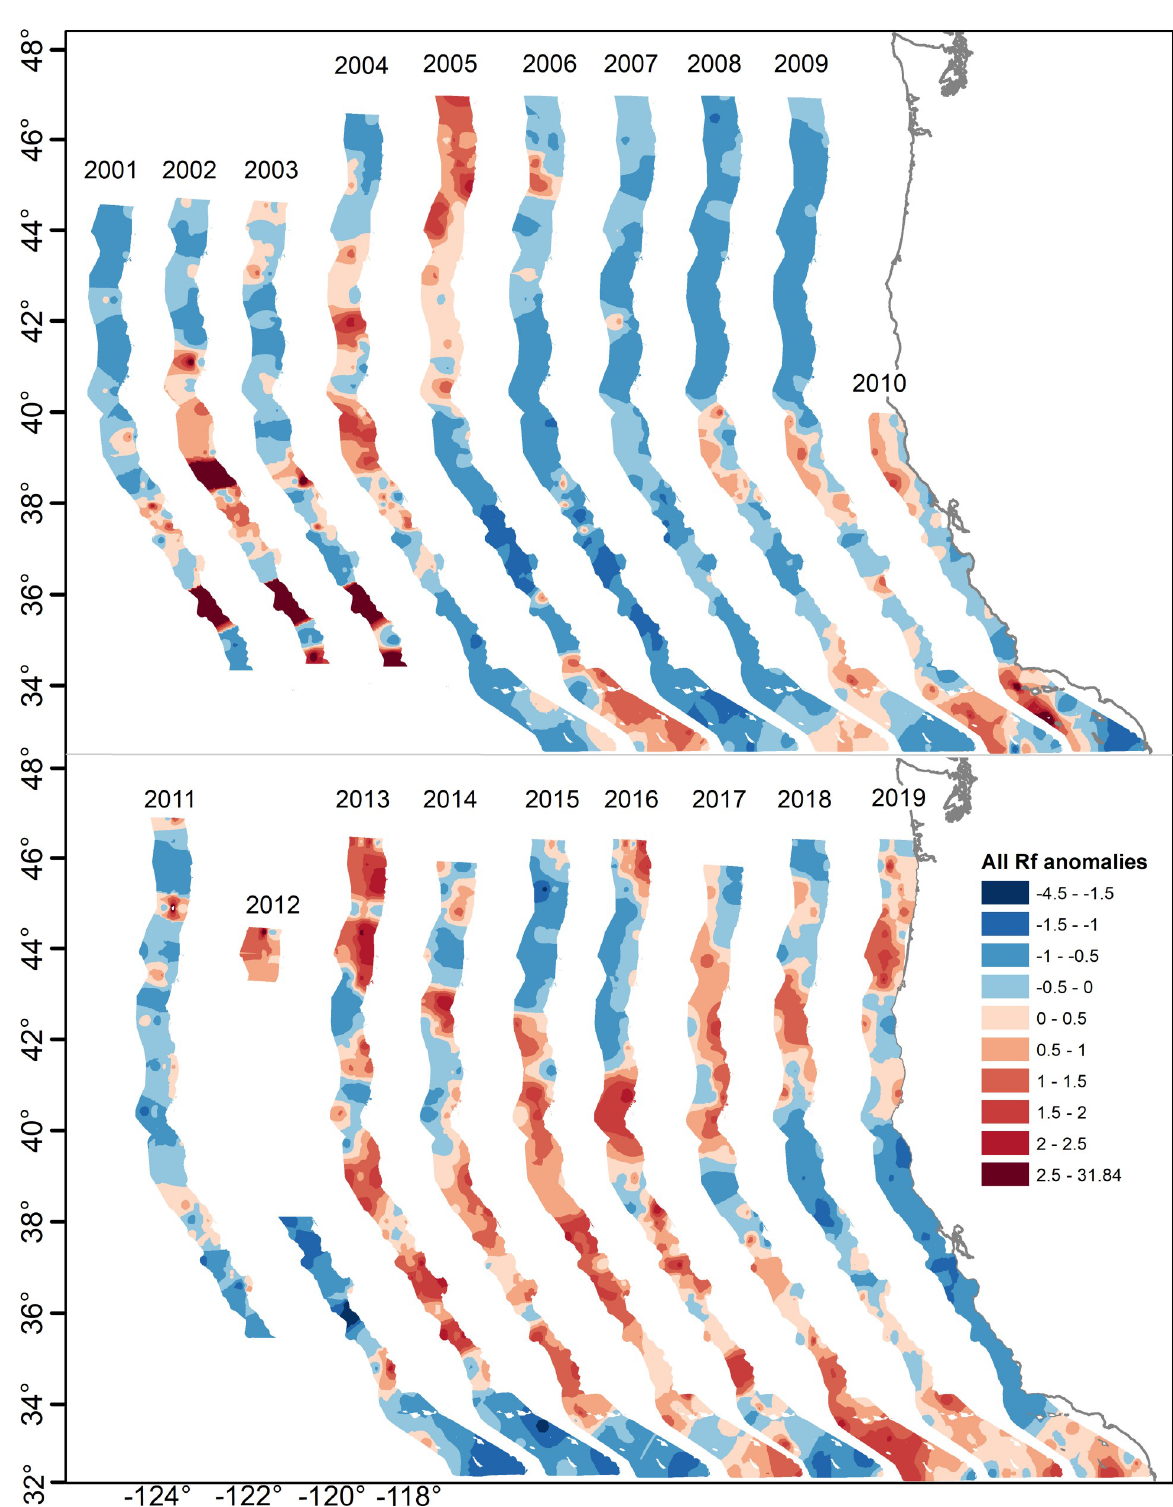
Fig 4. Interannual variability in relative pelagic young-of-year rockfish abundance, based on spatially explicit (station specific) z-scores from climatology years.